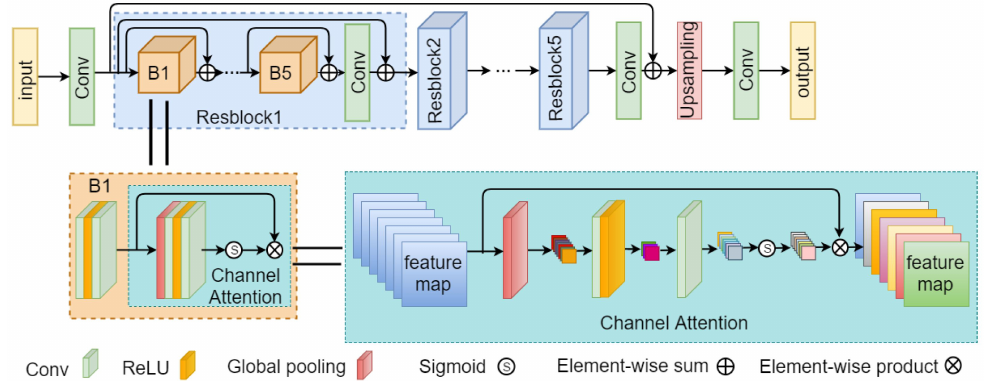
Figure 3. The super-resolution network of our closed-loop